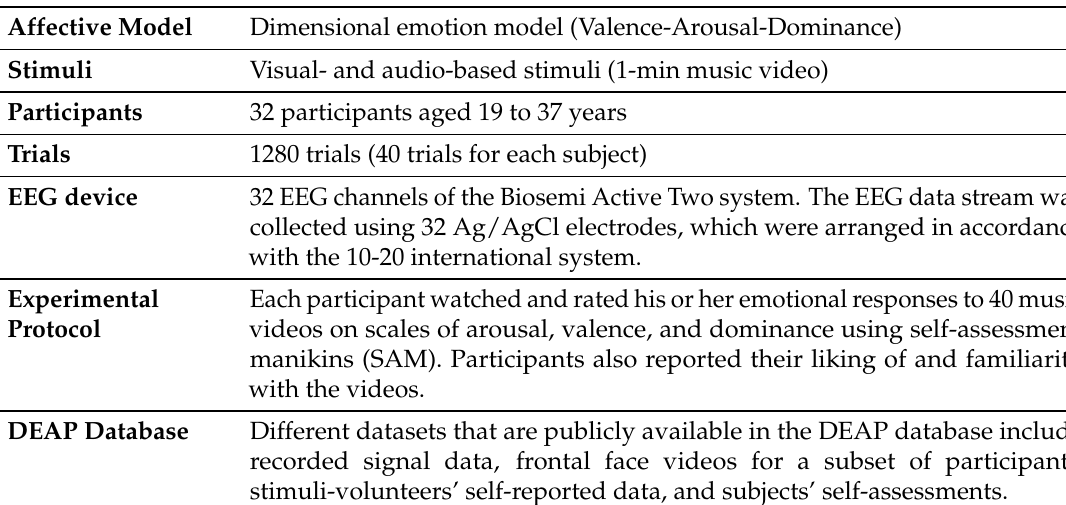
Table 7. DEAP dataset